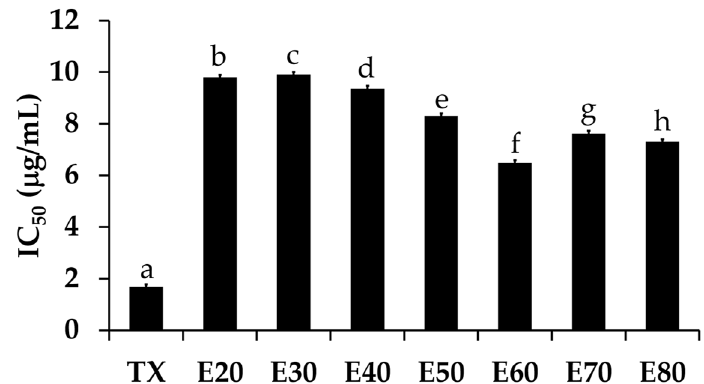
Figure 4. The IC 50 values of the ABTS • + scavenging activity of trolox (TX) and Sripanya pomegranate peel extracts. E20, E30, E40, E50, E60, E70, and E80 were Sripanya pomegranate peel extracts obtained by maceration in 20%, 30%, 40%, 50%, 60%, 70%, and 80% v/v of ethanol. Different letters denote statistically significant differences among groups; ( p < 0.05).